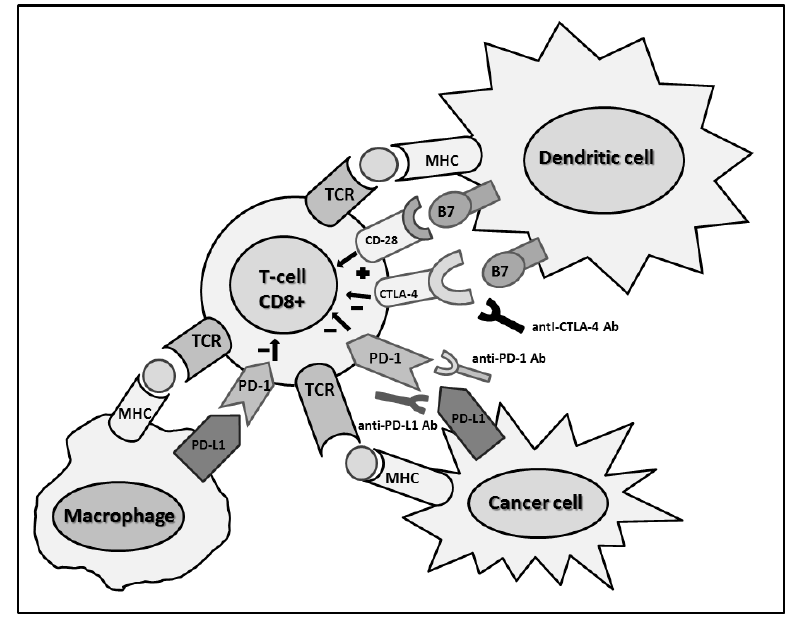
Figure 1. Cytotoxic T-lymphocyte-associated protein 4 (CTLA-4) and PD-1/L1 checkpoint blockade. MHC, major histocompatibility complex; TCR, T cell receptor; PD-1, programmed cell death-1; PD-L1, programmed cell death ligand-1; +, B7 receptor expressed; − , B7 receptor not expressed.